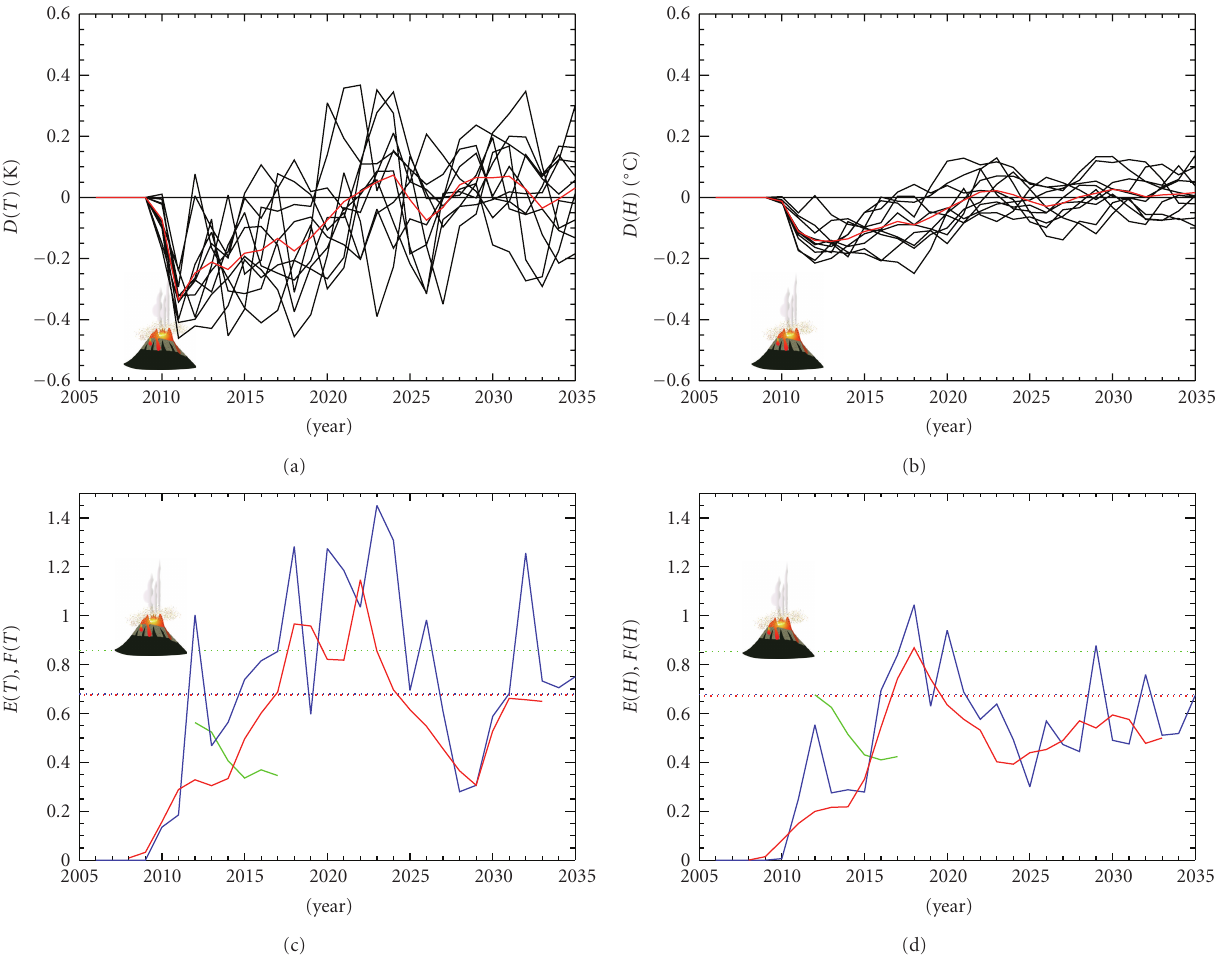
Figure 2: (a) Black and red lines indicate D i and D for the global mean T , respectively (K). (c) Blue and red lines show E ( T ) for the annual mean and the 5-yr running mean T , respectively. Green line is F ( T ) for the 5-yr running mean T of the HIND runs, where the year 2010 means the 1st year of hindcast. Dotted lines denote the 10% significance levels of F -test. Right panels are the same as the left panels, except for the average ocean temperature in the upper 125 m ( H